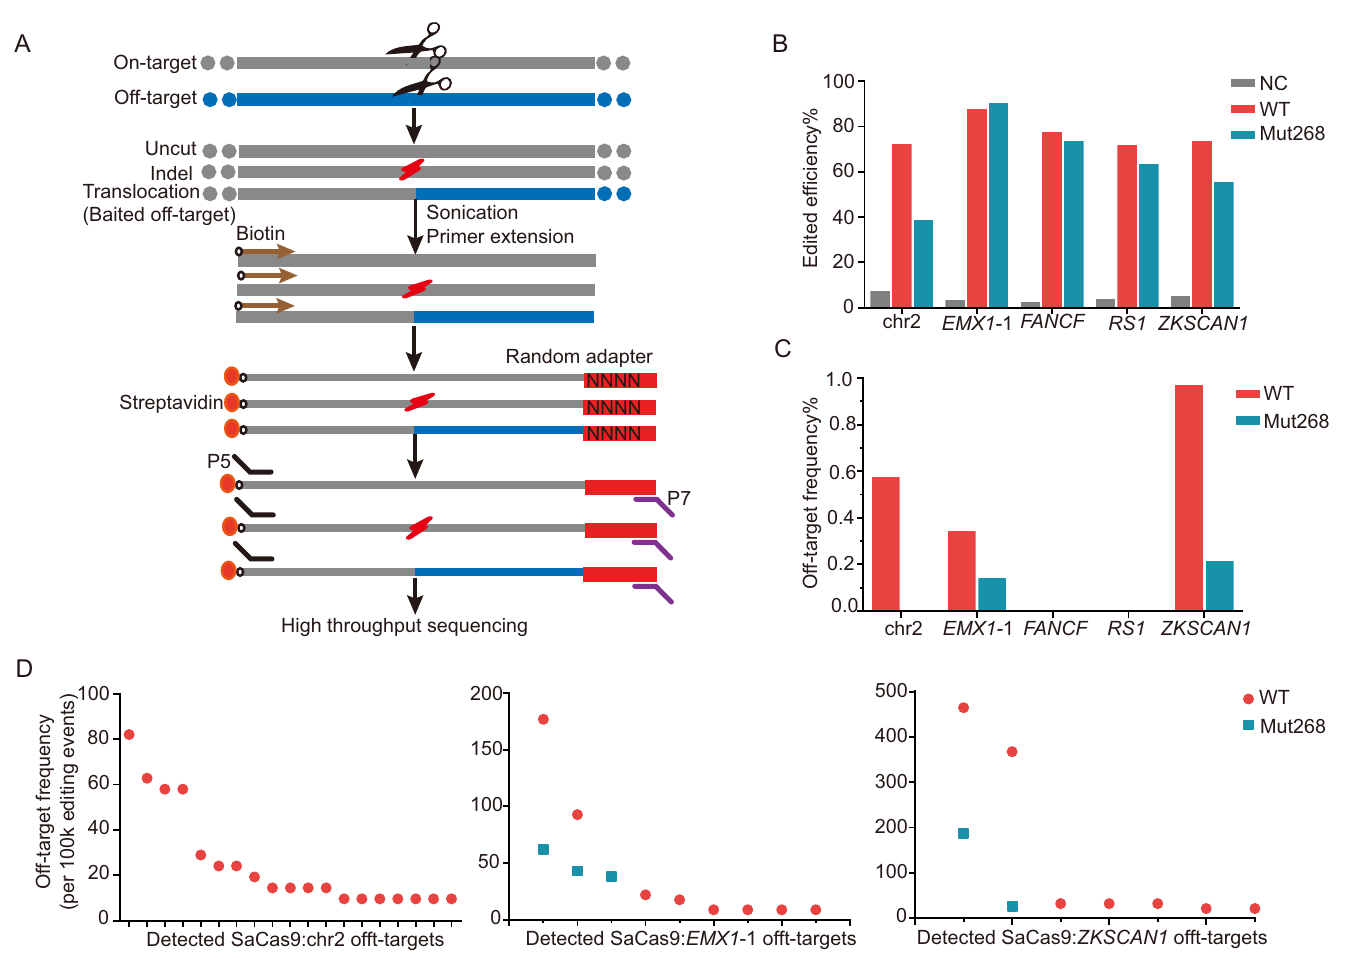
Fig 3. Mut268 possesses lower off-target effects at genome-wide levels. (A) Schematic of PEM-seq. (B) Edited efficiency for WT SaCas9 and Mut268 detected by PEM-seq. chr2 represents chr2:156,968,467–156,968,493 locus. (C) Off-target frequency for WT SaCas9 and Mut268 detected with PEM-seq. (D) Scatter plot of indicated off-target hotspots for WT and Mut268. y-Axis showed frequency of each hotspot per 100,000 editing events (in/dels plus translocation). in/del, insertion or deletion; PEM-seq, primer-extension-mediated sequencing; SaCas9, Staphylococcus aureus Cas9; WT, wild-type.